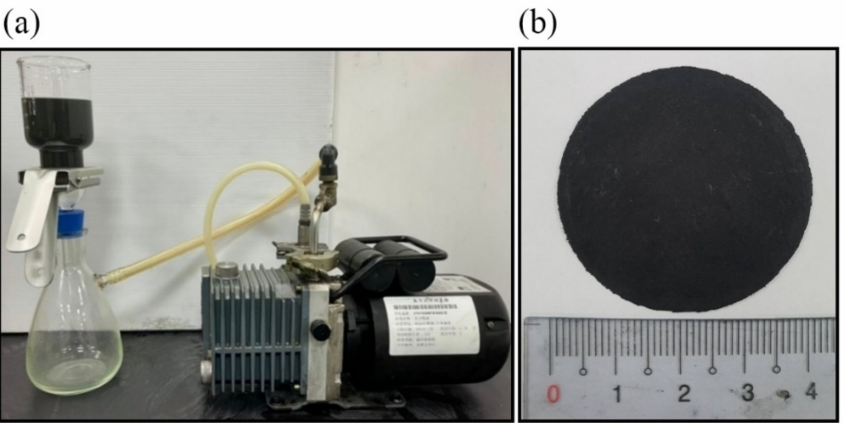
Figure 1. ( a ) Pumping filtration system; ( b ) Appearance of the fabricated buckypaper